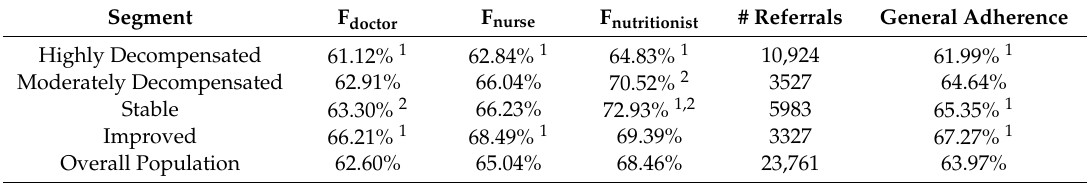
Table 4. Evolution segment adherence for group referrals from a specific discipline to any other discipline.